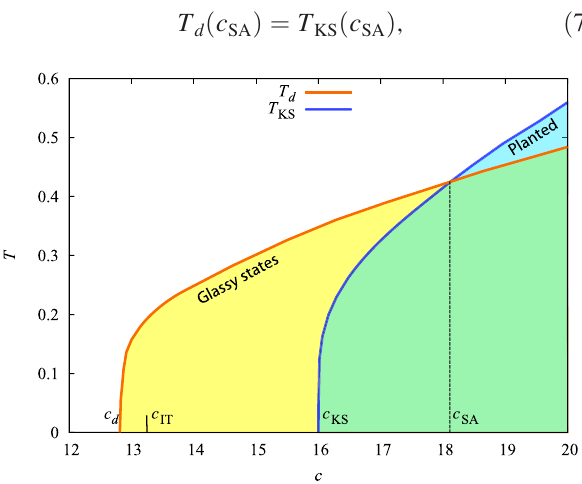
FIG. 3. Phase diagram in the c - T plane for the planted-coloring problem with q ¼ 5 . T d ð c Þ is the critical line below which glassy c Þ the paramagnetic solution states appear, while below T KS ð becomes unstable toward the planted solution. The information- theoretical threshold c corresponds to c c , while we claim that IT SA is not able to find the planted solution for c < c . We can SA c Þ . Both in extract c as the connectivity at which T d ð c Þ ¼ T SA KS ð the yellow and the green region, a MCMC algorithm gets trapped in glassy states, and the only region in which it can nucleate the planted solution is the blue one. On the other hand, the BP algorithm finds the paramagnetic solution in the yellow region, while it succeeds to find the planted solution both in the blue and in the green